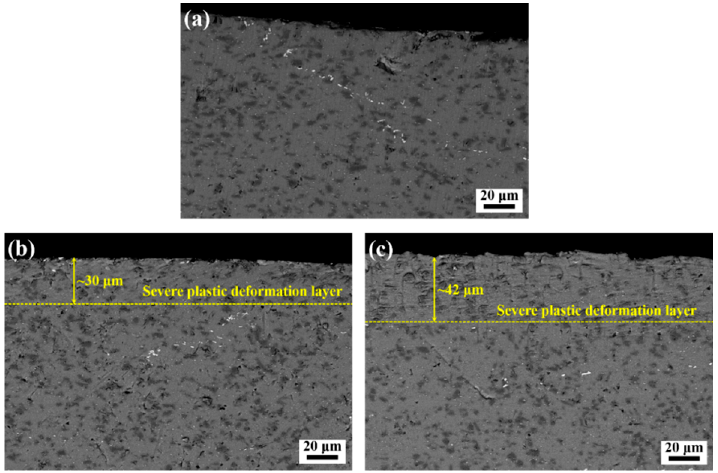
Figure 2. Scanning electron microscope (SEM) images illustrating the cross-sectional microstructures in the ( a ) base material (BM), ( b ) TLSPed-20 J and ( c ) TLSPed-30 J specimens.